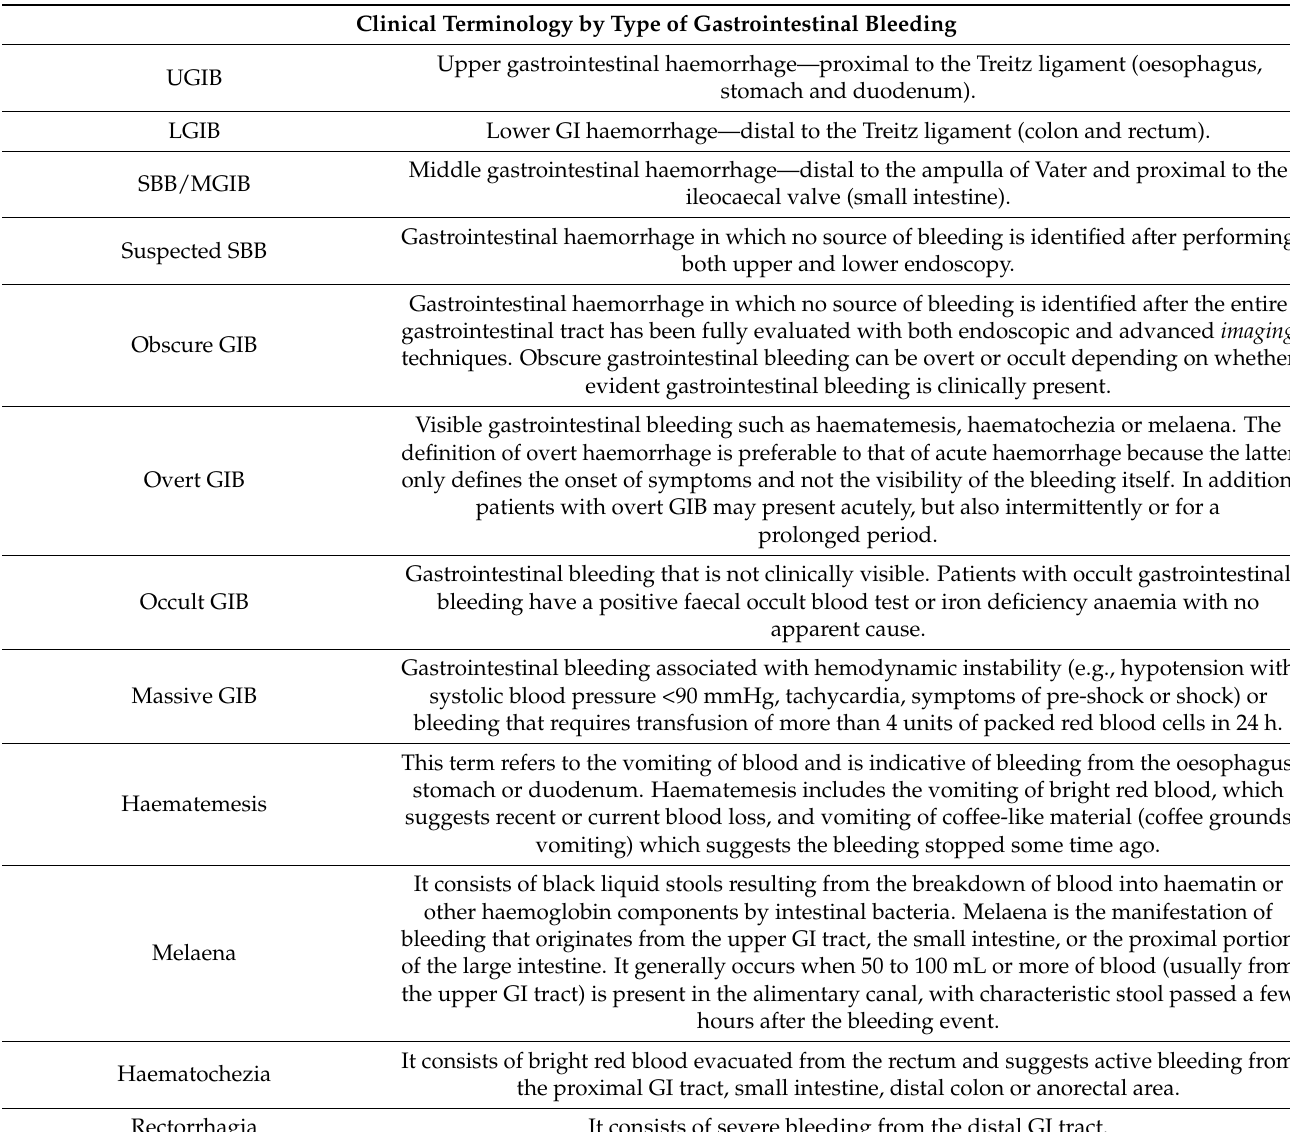
Table 1. Clinical terminology and glossary of clinical signs in gastrointestinal